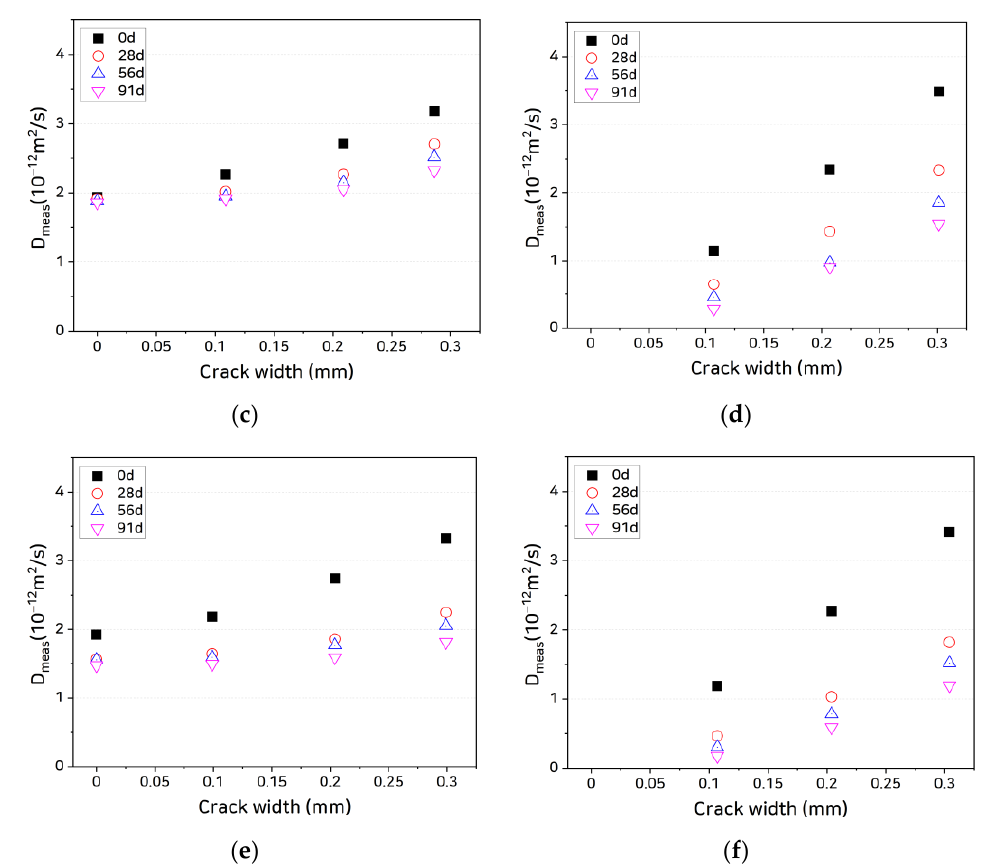
Figure 7. Measured diffusion coefficients of specimens as functions of crack width and healing age: ( a ) OPC, uncoated; ( b ) OPC, coated; ( c ) SHC15, uncoated; ( d ) SHC15, coated; ( e ) SHC30, uncoated; and ( f ) SHC30, coated.